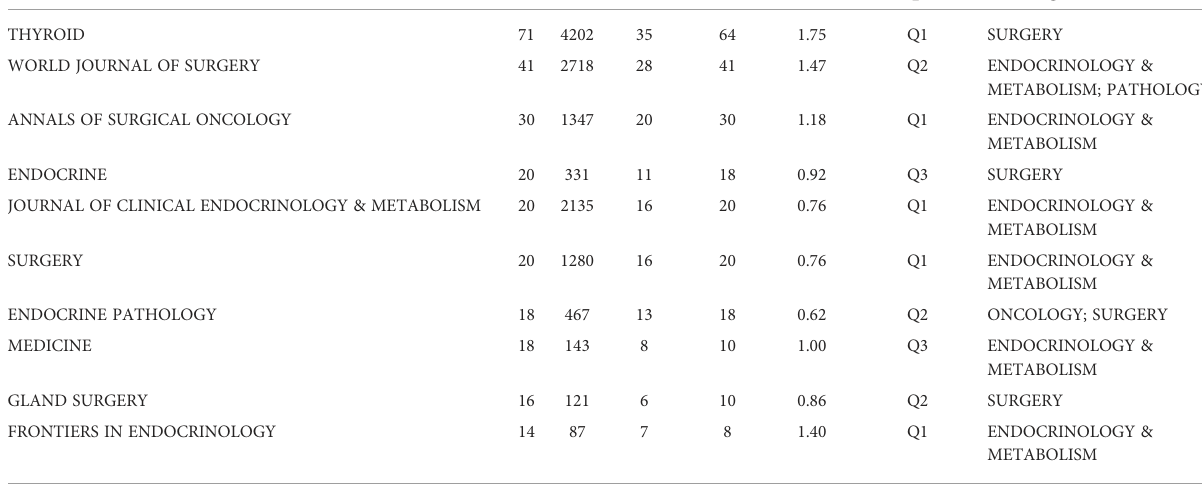
TABLE 3 The core journals that published publications in PTMC fi